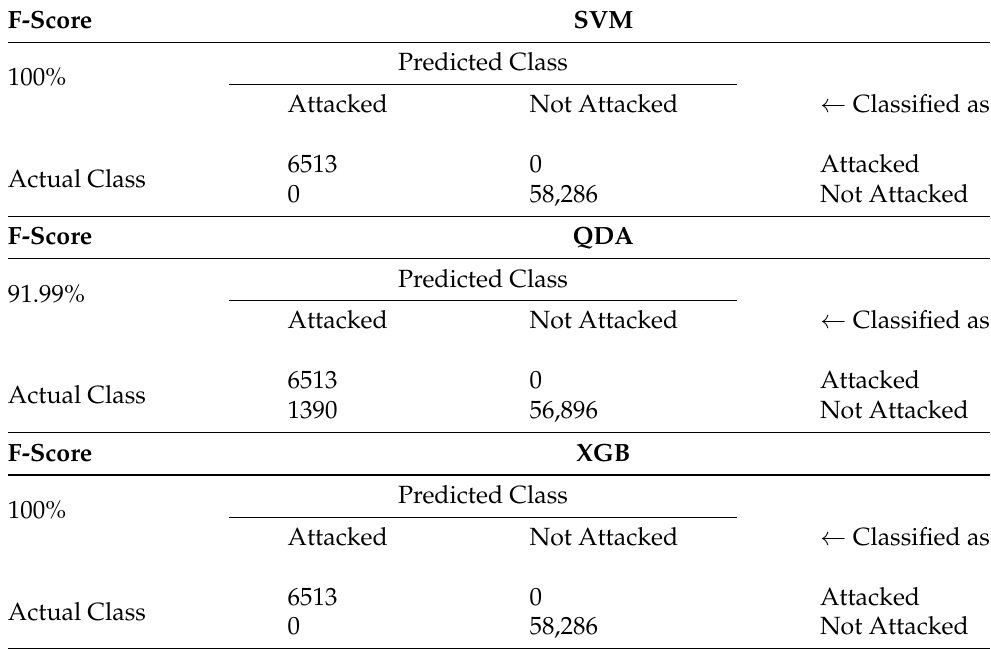
Table 6. Sample of the performance for scenario